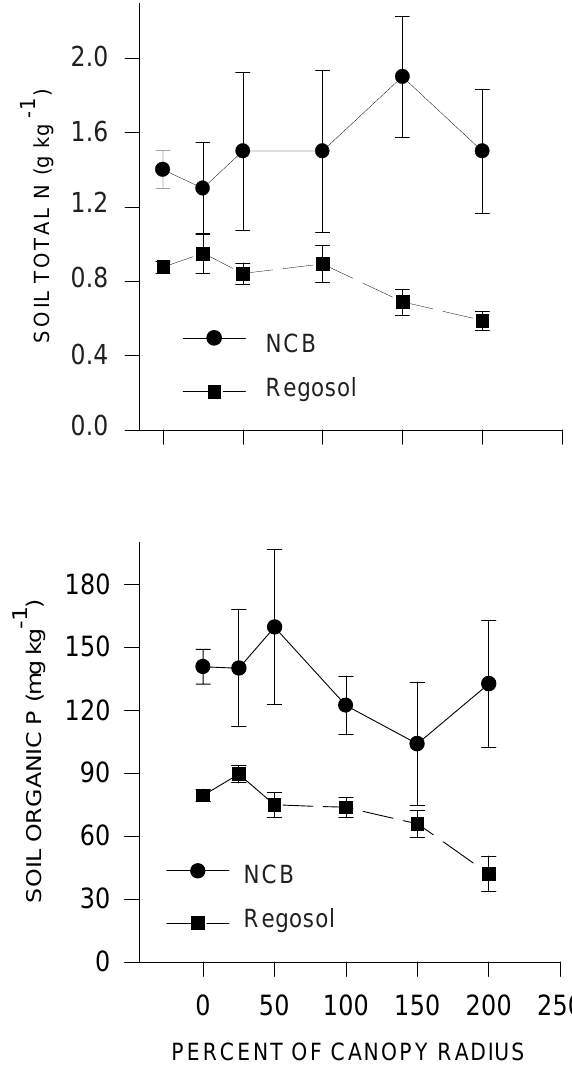
Figure 1. Soil total N and organic P under and next to the canopy of S. tuberosa trees located in areas of Noncalcic Brown (NCB) and Regosol in Custódia, PE. Error bars represent the standard error of the mean for NCB (n = 3) and Regosol (n = 4)